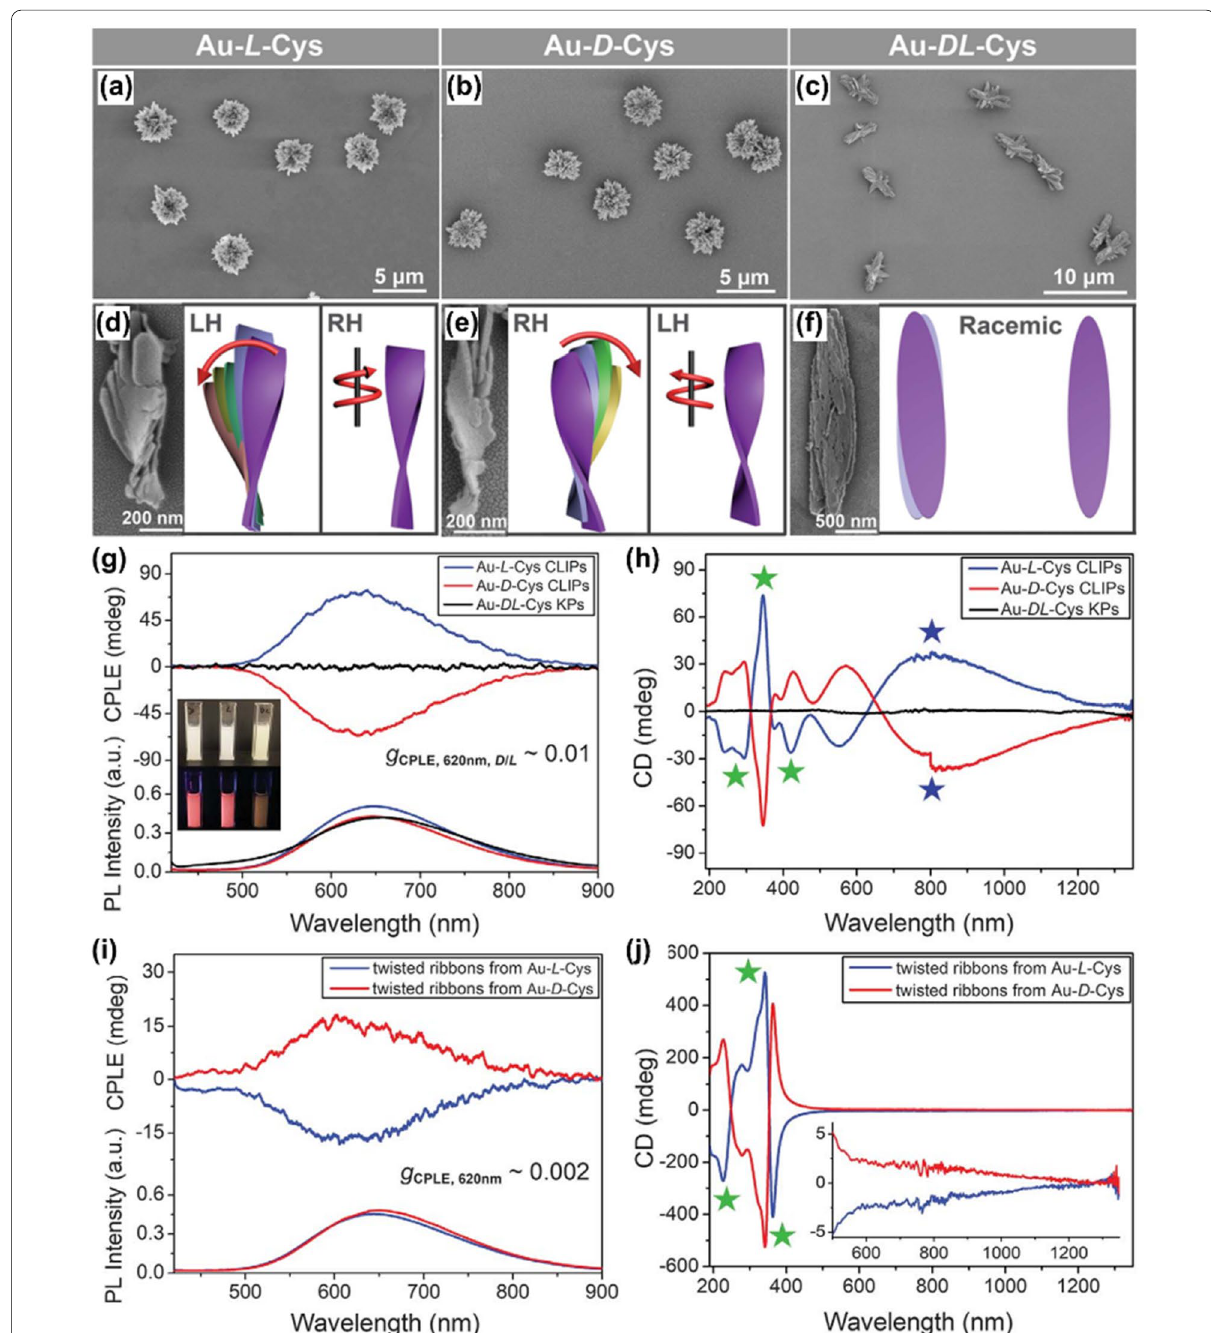
Fig. 13 Au thiolate hierarchically organized particles (HOPs) with Cys ligands. a – c SEM images of Au– l -Cys and Au– d -Cys coccolith-like particles (CLIPs) ( a and b ) and Au– DL -Cys kayak particles ( c ). d – f SEM images and corresponding schematic illustrations of segments of Au– l -Cys ( d ), Au– d -Cys ( e ), and Au– dl -Cys ( f ). g , h CPP ( g ) and CD ( h ) spectra of Au– l -Cys CLIPs (blue), Au– d -Cys CLIPs (red), and Au– dl -Cys kayak particles (black). Inset in g Photos of Au– l -Cys, Au– d -Cys, and Au– dl -Cys dispersions under daylight (top) and UV light (bottom) illumination. i , j circularly polarized emission ( i ) and CD ( j ) spectra of Au– l -Cys (blue) and Au– d -Cys (red) after sonication. Inset in j The same spectra for the 500- to 1350-nm spectral window to confirm the absence of the CD peaks associated with differential scattering of assembled CLIPs. The helicity of the nanoribbon stacks of Au– l -Cys is left-handed, and therefore the light scattered by Au– l -Cys has left-handed polarization. After disassembly of the stacks into single right-handed nanoribbons, the light passing through these dispersions acquires right-handed circular polarization. Reproduced with